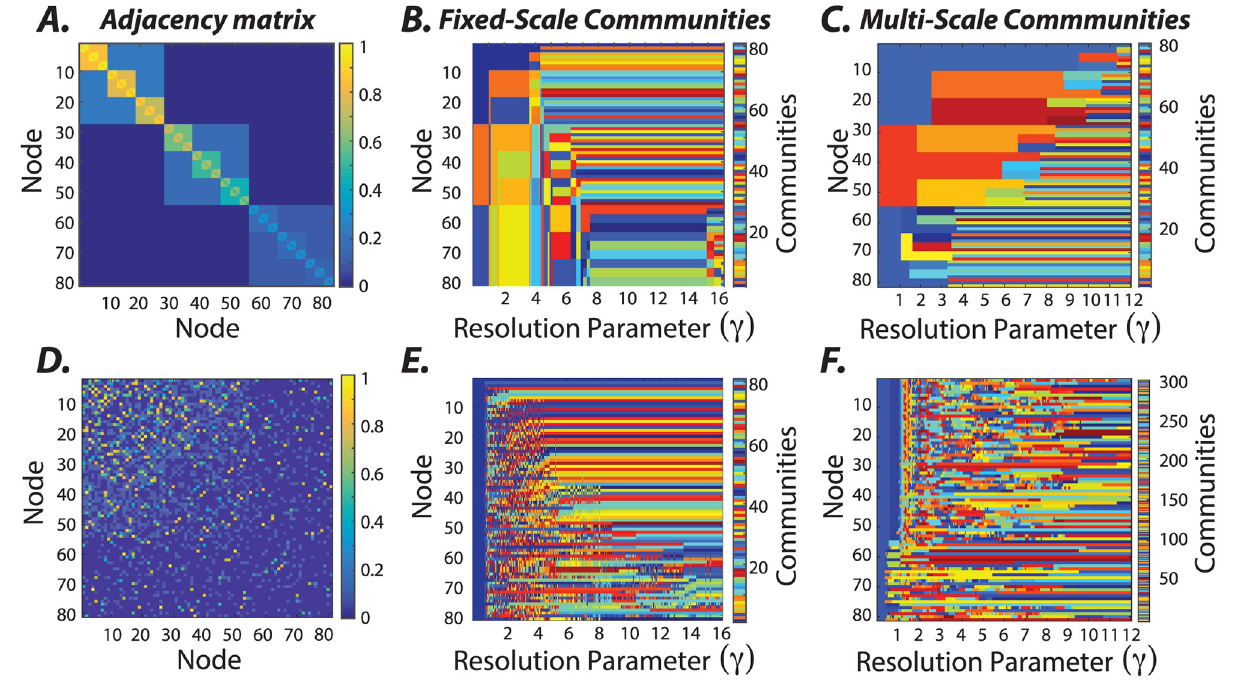
Fig 2. Uncovering hierarchical community structure in a synthetic graph. (A) Graphs can display heterogeneity in hierarchical community structure. To gain intuition regarding the utility of our method for characterizing these sorts of graphs, we design a synthetic graph such that each node is part of a small cluster composed of 3 nodes, a medium sized cluster composed of 9 nodes, and a large cluster composed of 27 nodes. Topological heterogeneity is introduced by adding gradients in the values of edge weights such that not all clusters of a given size have the same average weight. (B) We seek to uncover the hierarchical structure in this synthetic graph. First, we use the more traditional approach of maximizing a single-layer modularity quality function [53] with the Newman-Girvan null model [57] using a Louvain-like locally greedy algorithm [54]. We sweep the resolution parameter between 1 and 16, and identify communities independently at each γ value. The limitation of this approach is that there is no guarantee that communities at one resolution correspond to communities at another resolution. (C) To overcome this limitation, we next seek to uncover the hierarchical structure in this synthetic graph using a multi-scale approach built on multi-scale community detection [31]. We find that the hierarchical community detection uncovers the true underlying community organization as we vary the value of the structural resolution parameter ( γ 2 [0, 12], τ = 0.05, an inter-layer γ increment of 0.05, and 241 layers). Moreover, the γ value at which a community is detected tracks the mean edge weight of the community; stronger communities are identified at larger γ values, and weaker communities are identified at smaller γ values. (D) For comparison, we created a null graph without any clear hierarchical community structure by randomly shuffling the edges of the graph in panel (A) , while preserving the weight, degree, and strength distributions (see [63] for details). Panels (E) and (F) show the communities detected in this null graph when using the parameter sweep method and the multi-scale community detection method, respectively. Note that the lack of hierarchy in the null graph is similarly echoed in the multi- scale community structure displayed in panel (F) , marked by predominantly small and unstable communities across topological scales.